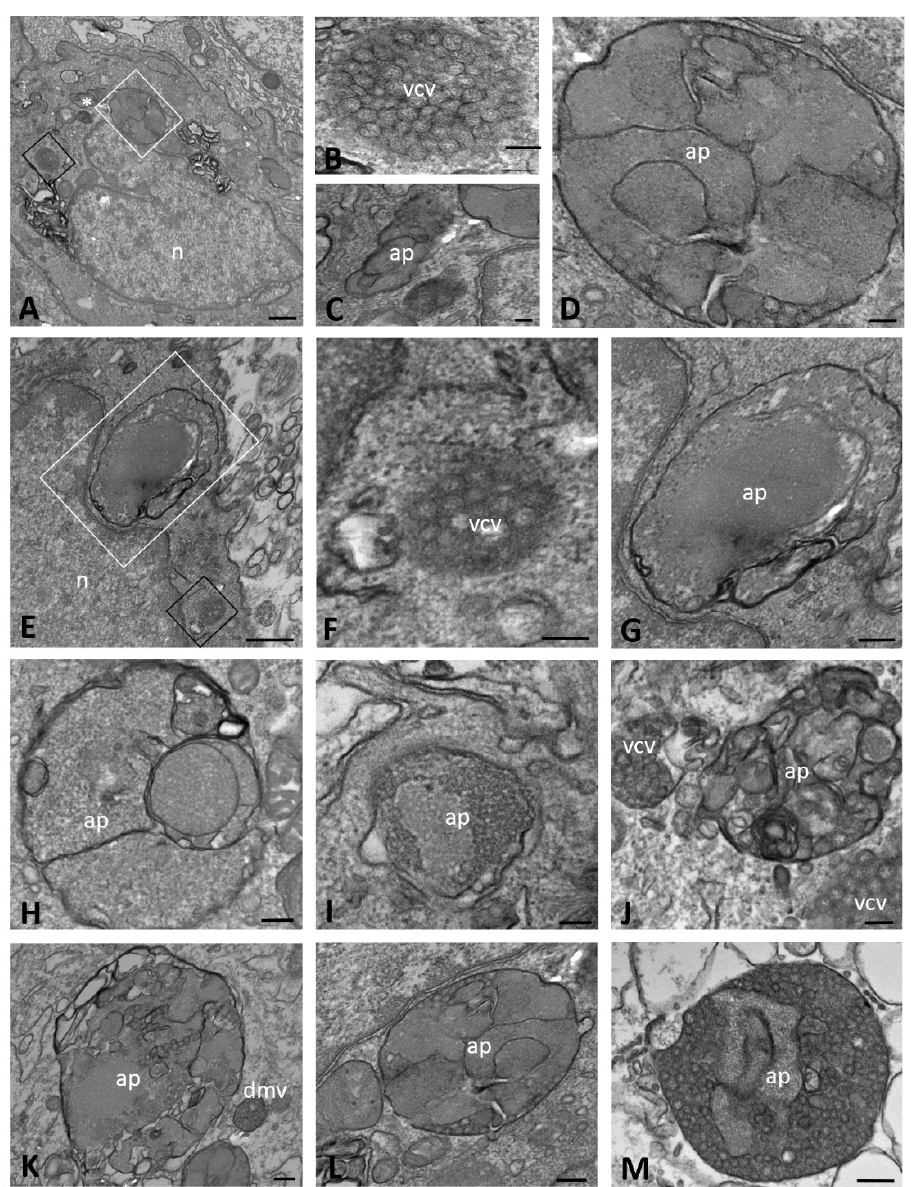
Figure 3. Transmission electron microscopy showing autophagosome structures at late time points of SARS-CoV-2 infection (from 24 to 72 h post infection) in CFBE41o- WT cells. Autophagosomes with a granular ( D , G – J ) or mixed content with evident viral particles ( D , K – M ) are detected. The black boxed area in ( A ) is enlarged in ( B ), the white boxed area is enlarged in ( D ) and the asterisk is enlarged in ( C ). The black boxed area in ( E ) is enlarged in ( F ) and the white boxed area is enlarged in ( G ). (ap): autophagosome; (n): nucleus; (vcv): virion-containing vesicle. Bars: ( A , E ) 500 nm; ( G , H , J , K , M ) 200 nm; ( B – D , F , I , L ) 100 nm.